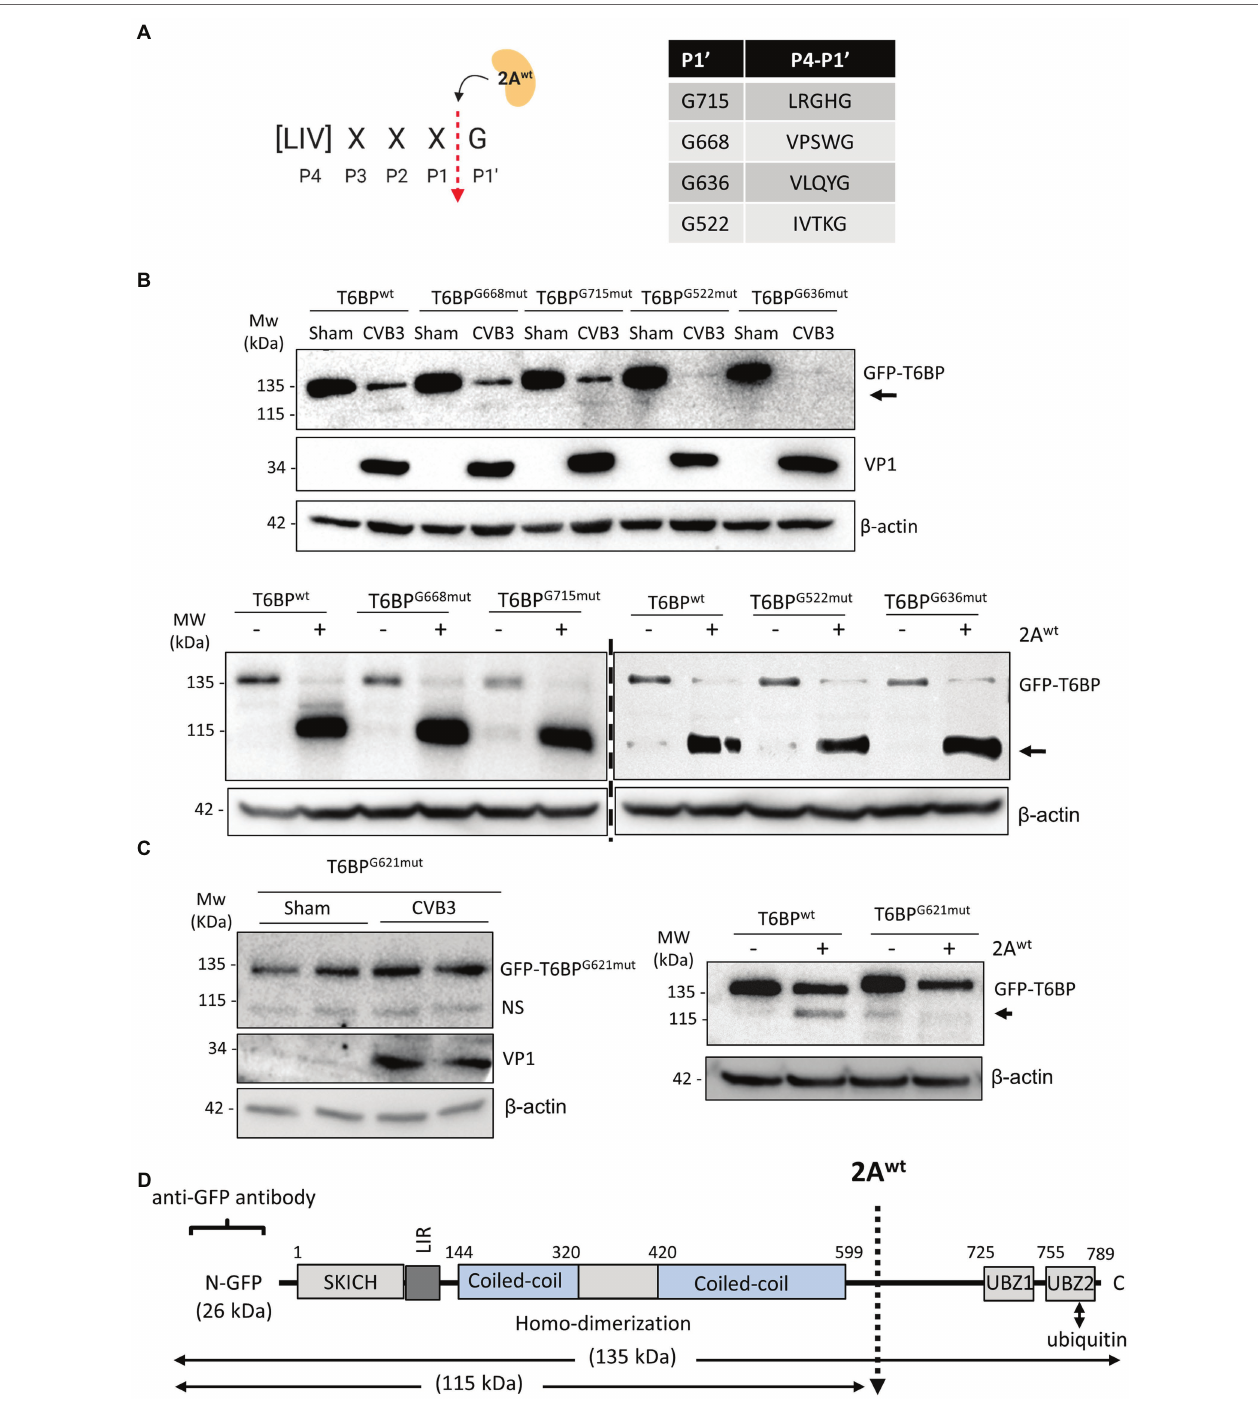
FIGURE 4 | 2A wt cleaves T6BP after G621. (A) Schematic depiction of 2A wt consensus cleavage site. Red arrow denotes the scissile cleavage between P1 residue and the conserved glycine (G) residue at P1 ′ . Right, consensus sequences identified in the open reading frame of T6BP and the respective P1 ' G residues. (B) HeLa cells were transfected with either GFP-T6BP wt or various mutants T6BP constructs as indicated. After 24 h, cells were sham or CVB3 infected for 7 h (upper panel) or collected for in vitro cleavage assay with purified 2A wt (bottom panel). Western blot analysis was conducted with anti-GFP and anti-VP1 antibodies. Arrows denote T6BP cleavage fragments. (C) HeLa cells were transfected with either GFP-T6BP wt or T6BP-G621 mut as indicated. After 24 h, cells were sham or CVB3 infected for 7 h (left panel; duplicates of each condition are shown) or harvested for in vitro cleavage assay with purified 2A wt (right panel). Western blotting was performed as above. NS, non-specific band. (D) Schematic illustration of the structural domains of T6BP, the identified cleavage site, the antibody recognition regions, and the resulting cleavage